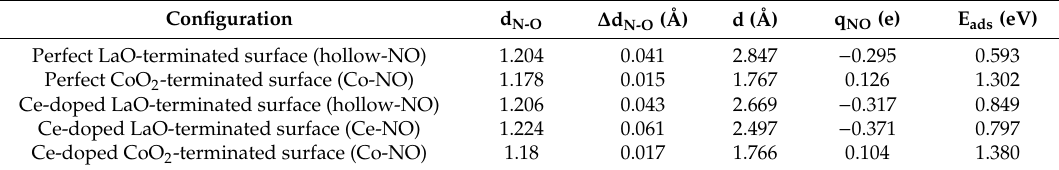
Figure 3. The optimized ( a ) La-NO and ( b ) hollow-NO configurations of the perfect LaO-terminated LaCoO 3 (011) surface; the optimized ( c ) hollow-NO and ( d ) Co-NO configurations of the perfect CoO 2 -terminated LaCoO 3 (011) surface. Table 1. Summary of the results of the NO molecule adsorbed on undoped and Ce-doped LaCoO 3 (011) surface. The properties listed are as follows: The N-O bond length (d N-O ), the N-O bond length difference between adsorbed and free NO molecules ( △ d N-O ), the equilibrium distance (d), Mulliken charges (q NO ), and the adsorption energy (E ads ).